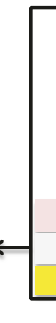
Figure 1: Design of paper-based analytical device: (a) support base, (b)Whatmanfilterpapercontentreagent1,(c)Whatmanfilterpaper content reagent 2, (d) Whatman filter paper content reagent